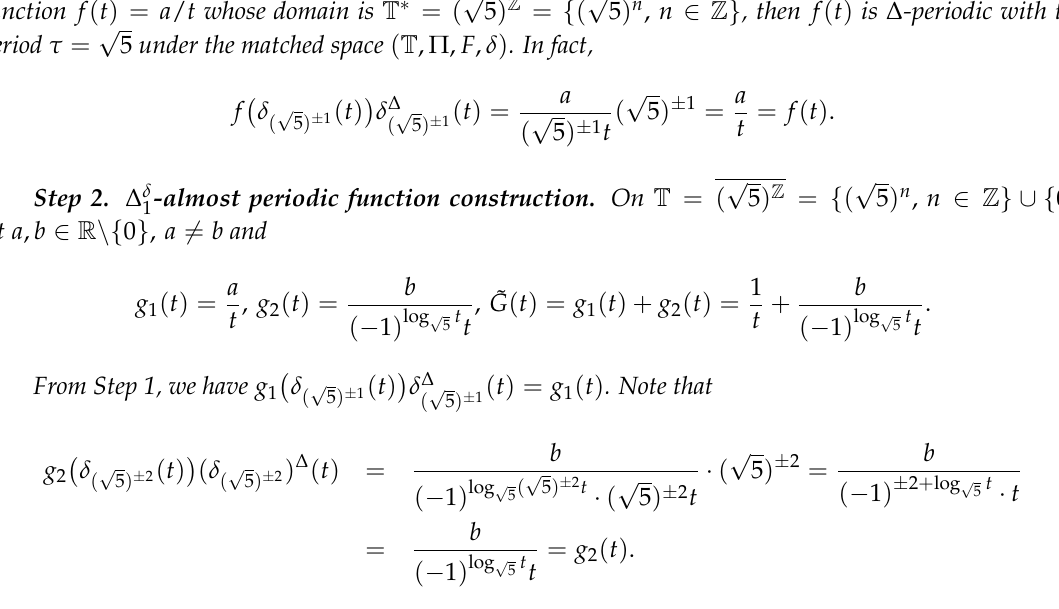
(cid:0) ln |√ 2 t | (cid:1) (cid:0) ln |√ 3 t | (cid:1) with P 1 = 2, P 2 = 3 + cos π π cos ln ( 1/ P 1 ) ln ( 1/ P 2 )